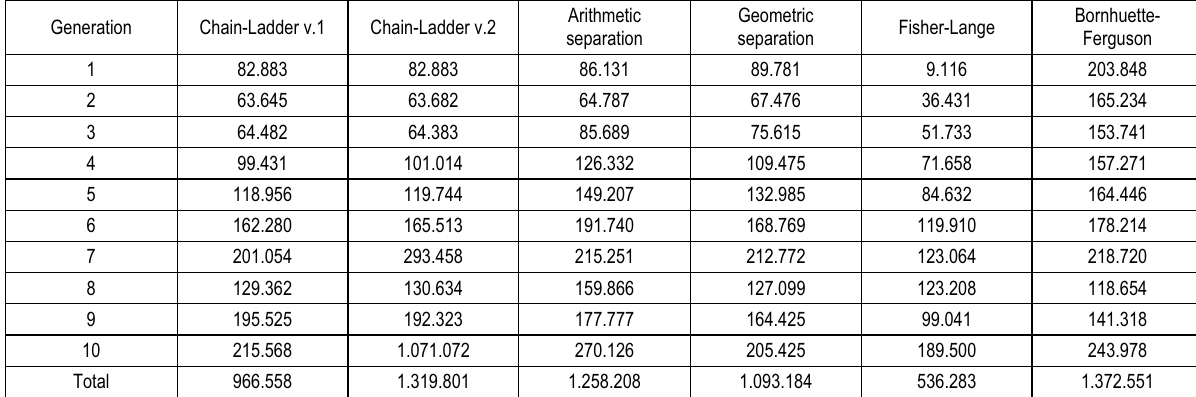
Table 11. Mean square error method of single settlements